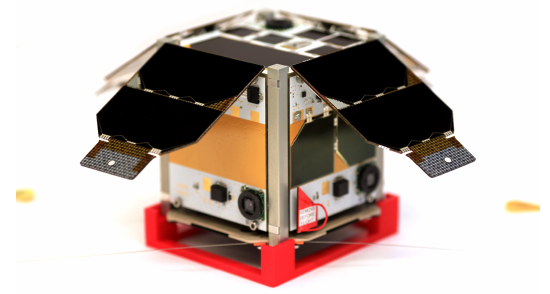
Figure 1. Munich Orbital Verification Experiment (MOVE)